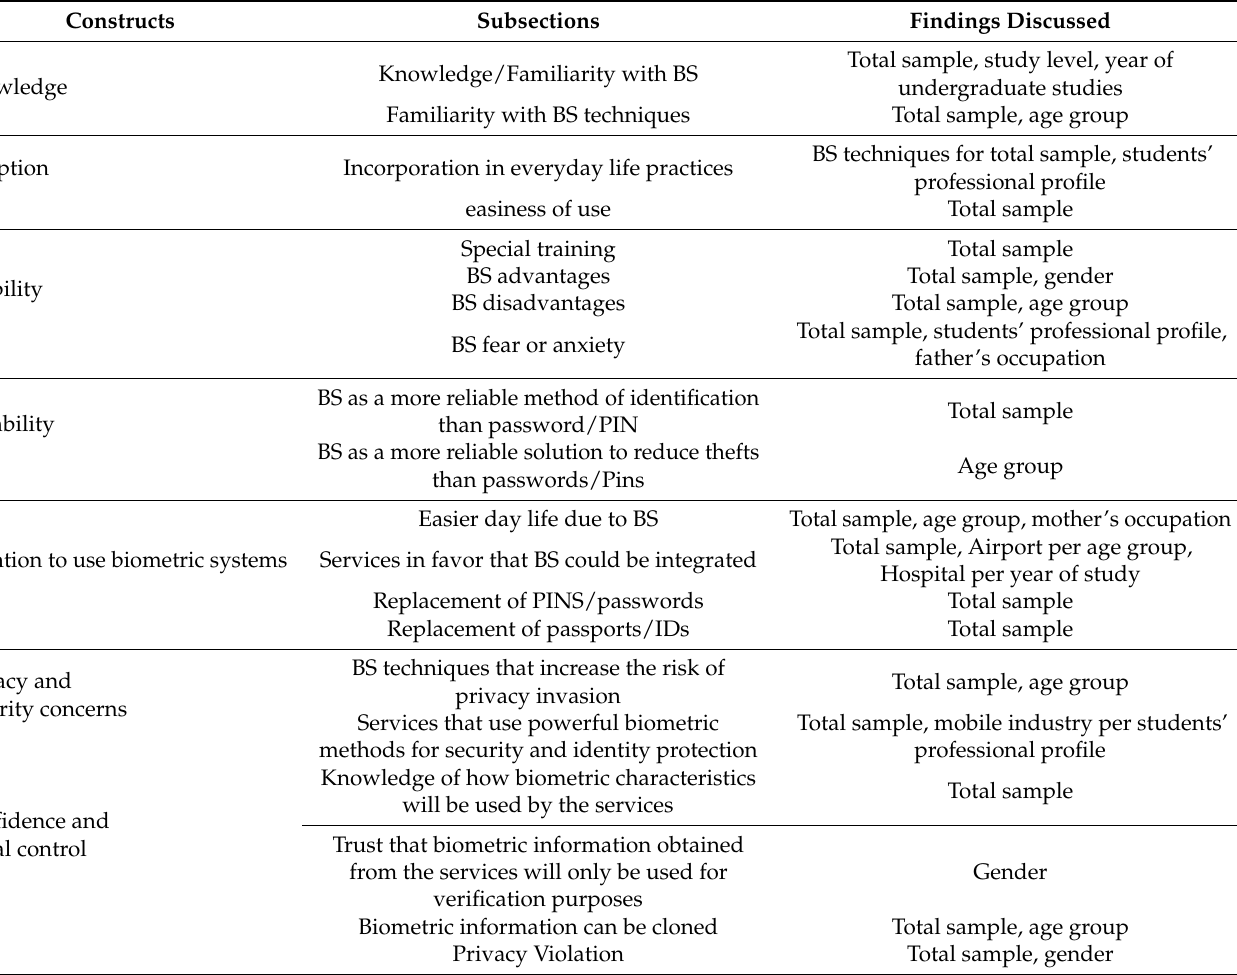
Table 2. Summary of the findings